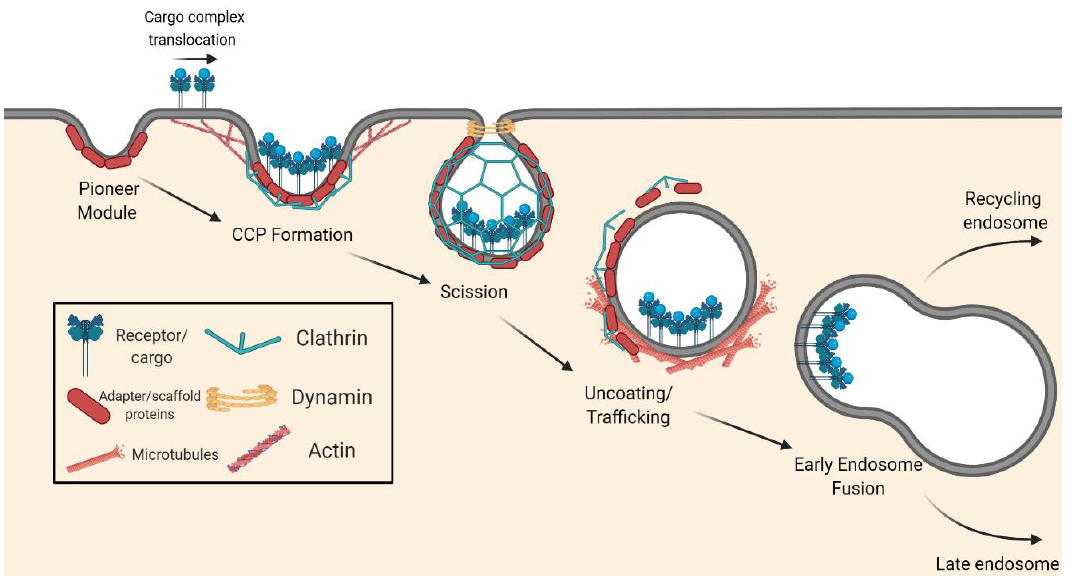
Figure 1. Schematic of the canonical clathrin-mediated endocytosis (CME) pathway. Initially, a group of adapter and scaffold proteins associate at the endocytic site, forming a pioneer module. This pioneer module then recruits coat-associated proteins, including clathrin, to the developing membrane invagination. The coat-associated proteins bind to the cytosolic regions of cargo complexes to recruit the cargo to the endocytic site. Membrane bending continues, in part due to mechanical forces from actin, and the clathrin coat expands until the clathrin-coated pit (CCP) is formed. Scission of the CCP is mediated by dynamin, which releases the clathrin-coated vesicle (CCV). The CCV then uncoats and undergoes trafficking via the cytoskeleton to the sorting endosome for further processing. Figure created with BioRender.com.